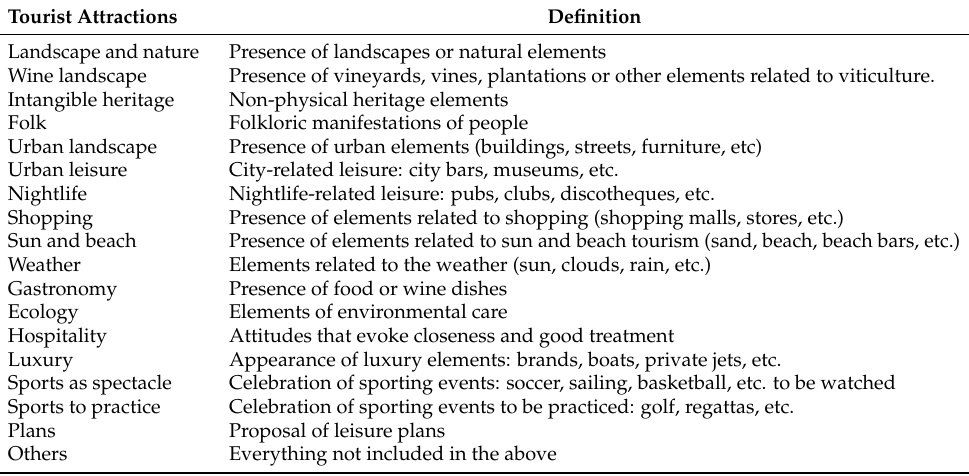
Table 2. Definition of tourist